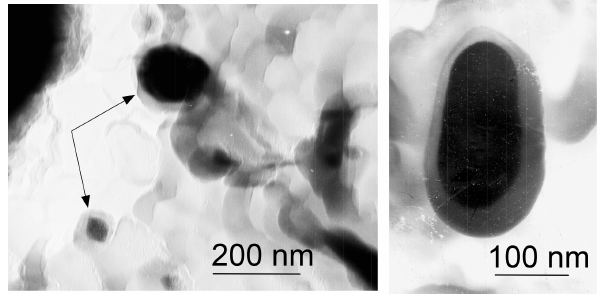
Figure 6. TEM images of micro-and nano-scale particles encapsu- lated by carbon shells (arrows) that were found in